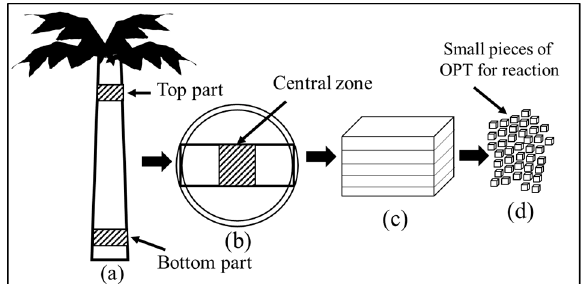
Figure 2. Preparation of the oil palm trunk (OPT) samples prior to the subcritical water (sub-CW) treatment. ( a ) Oil palm tree illustrating the top and bottom sections, ( b ) disc-shaped trunks indicating central zone, ( c ) segmented central zones stacked together, and ( d ) small pieces of OPT from the segmented central zone.